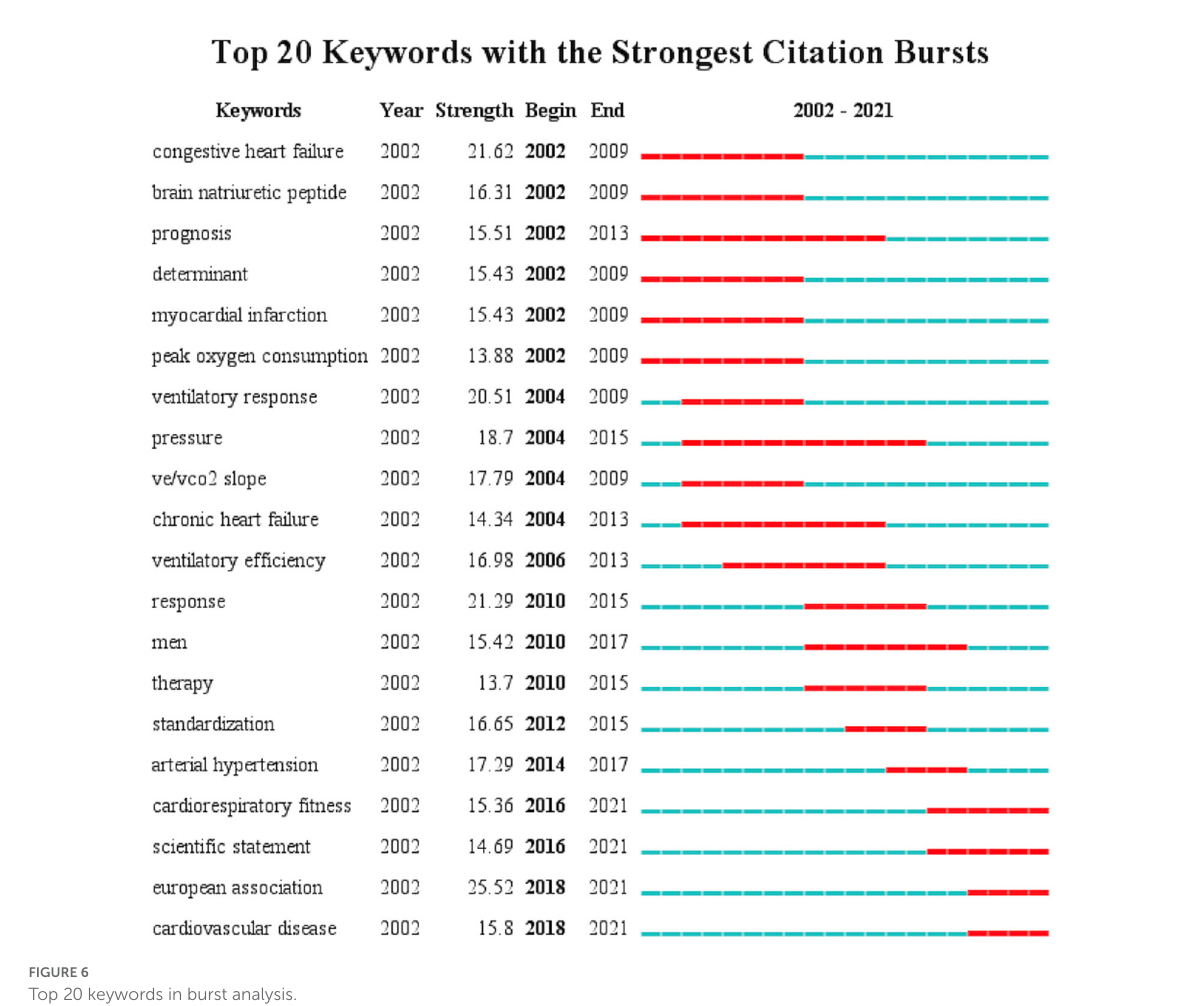
FIGURE6 Top 20 keywords in burst